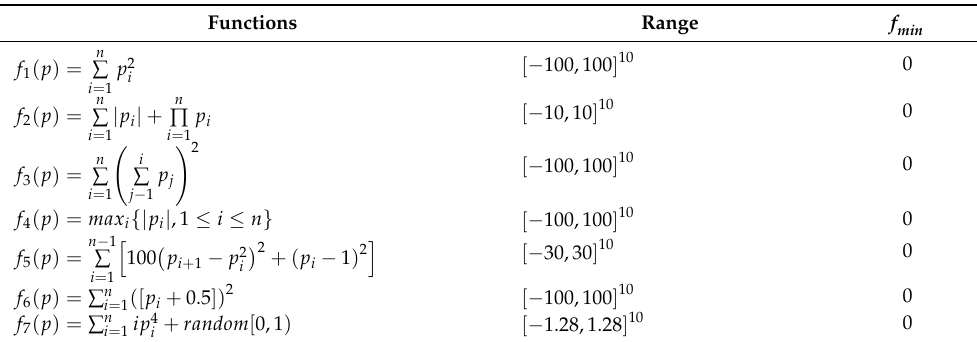
Table 1. Unimodal benchmark functions.